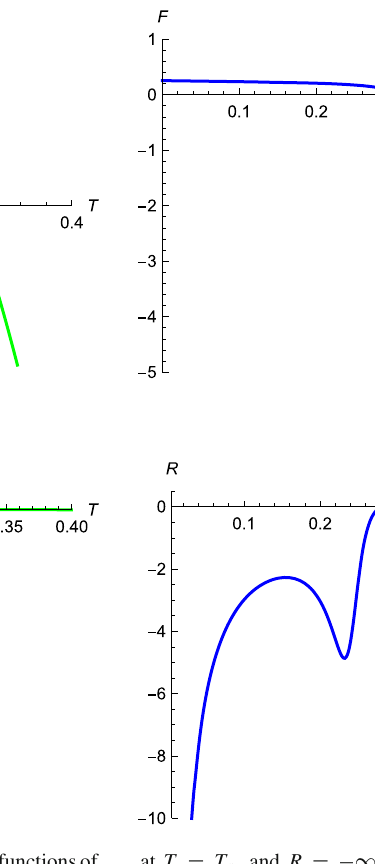
T < T 0 ≈ 0 . 318, where T 0 is the temperature of the first- order phase transition line at Q = 0. For T c < T < T 0 , Large BH and Small BH can coexist for some range of (cid:2) with some value of Q , which is determined by the first-order phase transition line (i.e., F ( LBH ) = F ( SBH ) ). We plot Q and R versus (cid:2) for T = 0 . 274 in the left column of Fig. 4, where the black line is the coexisting line of Large BH and Small BH. Since Eq. (10) is not applicable on the coexisting line, we do not plot R for the coexisting line. The lower-left panel of Fig. 4 shows that R of Large BH is always negative and becomes divergent at the minimum value of (cid:2) , − 1 = 0 and LBH is unstable and undercharged. For where C Q Small BH, R is negative and becomes divergent as (cid:2) → 1. The unstable and overcharged Small BH also has R = −∞ − 1 = 0. The green and blue solid lines represent when C Q the globally stable phase, R of which is always negative and becomes divergent as (cid:2) → 1 . We plot Q and R versus (cid:2) for T = 0 . 3 in the right column of Fig. 4. The Maxwell equal area rule is not applicable here since there is a jump of the free energy at ((cid:2), Q ) = ( 0 , 0 ) on the isothermal (cid:2) - Q line. When (cid:2) is small enough, the inset shows that R